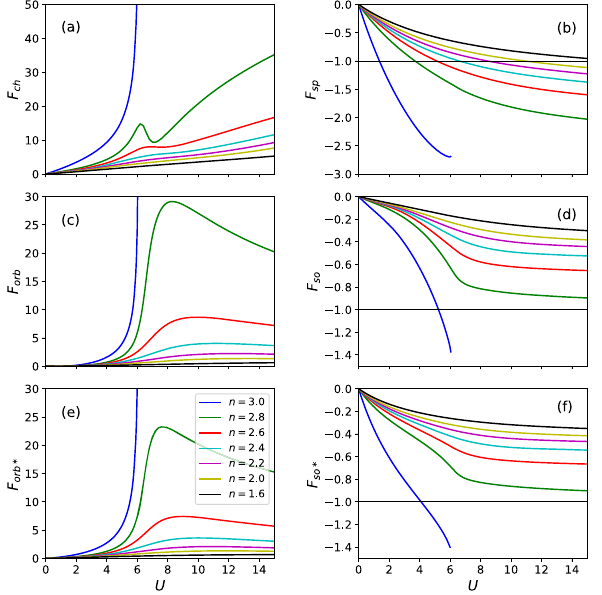
FIG. 6. The Landau parameters in the (a) charge, (b) spin, (c) orbital, (d), spin-orbital, (e) orbital*, and (f) spin-orbital* channel defined in Eq. (5) as a function of coulomb interaction U and J ¼ U= 4 for filling n ¼ 3 . 0 , 2.8, 2.6, 2.4, 2.2, 2.0, 1.6 and T ¼ 0 . 0005 t .